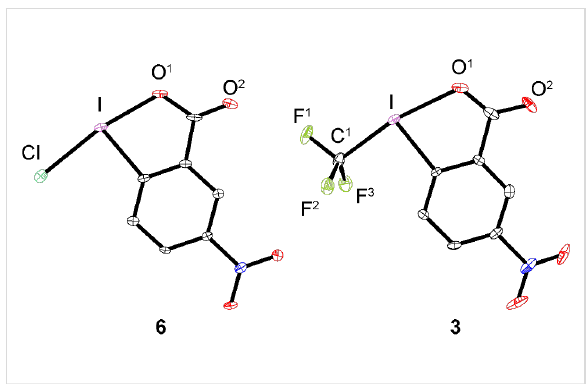
Figure 3: ORTEP representation of X-ray structures 6 and 3 . Thermal ellipsoids set to 30% probability. Hydrogen atoms omitted for clarity.